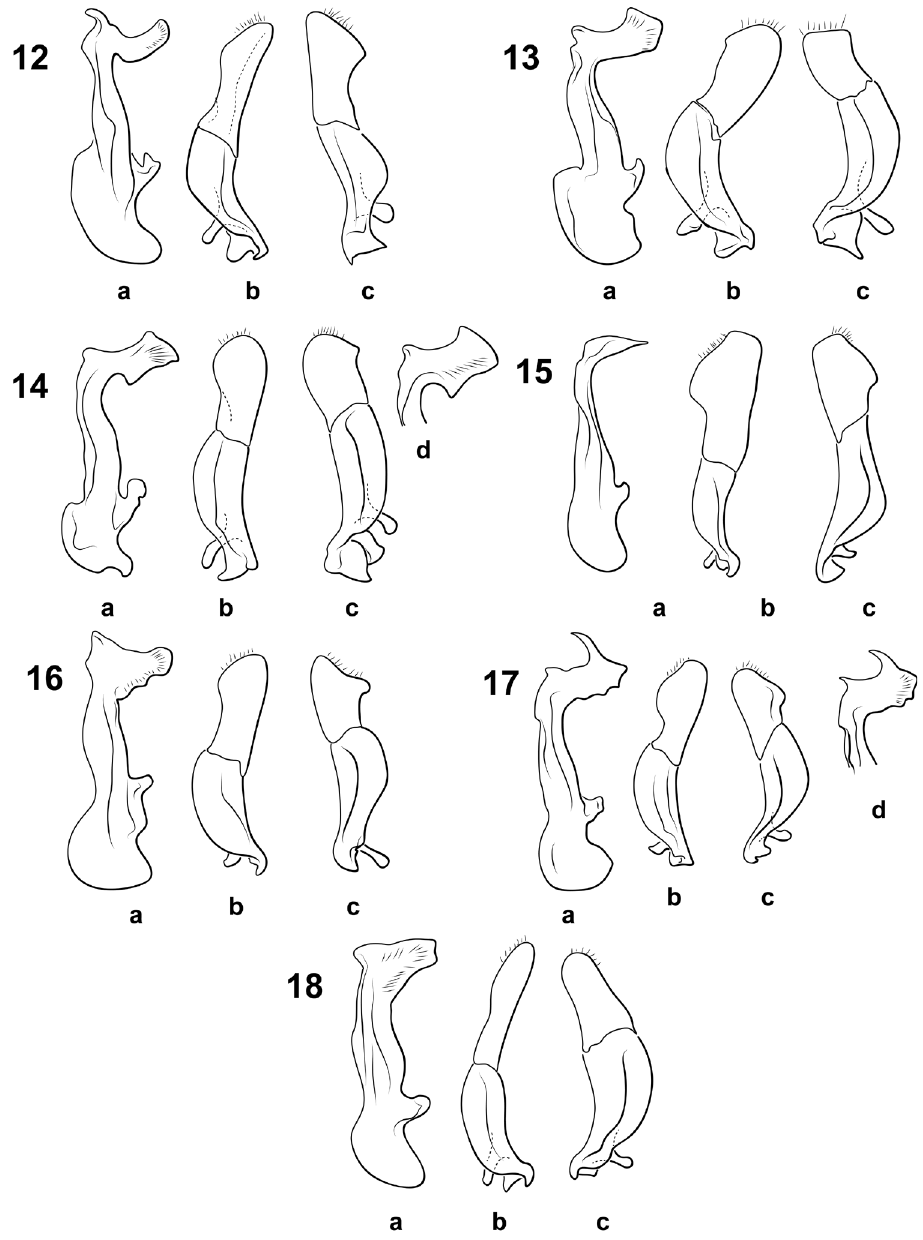
Figures 12–18. Bidessonotus species, male genitalia A median lobe, right lateral aspect B right lateral lobe, right lateral aspect C left lateral lobe, apical segment, left lateral aspect D median lobe apex, oblique right lateral aspect 12 B. annae 13 B. josiahi 14 B. palecephalus 15 B. reductus 16 B. septimus 17 B. spi- nosus 18 B. valdezi